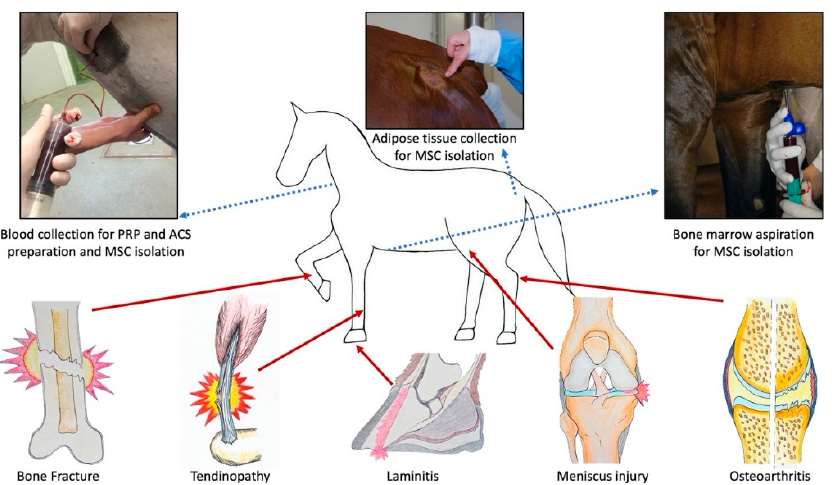
Figure 1. Illustration of the equine musculoskeletal diseases discussed in this review and the harvest sites for bone marrow (from the sternum), adipose tissue (from the tail head) and blood (from the jugular vein) for mesenchymal stem cell (MSC) isolation, respectively, for platelet-rich plasma (PRP) and autologous conditioned serum (ACS) preparation.